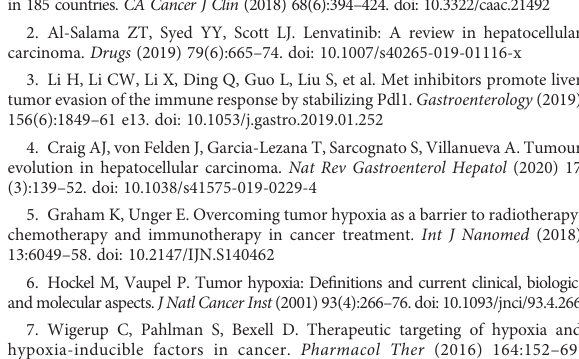
SUPPLEMENTARY FIGURE 1 Overview of study design. Flowchart of the steps in the performed analyses.